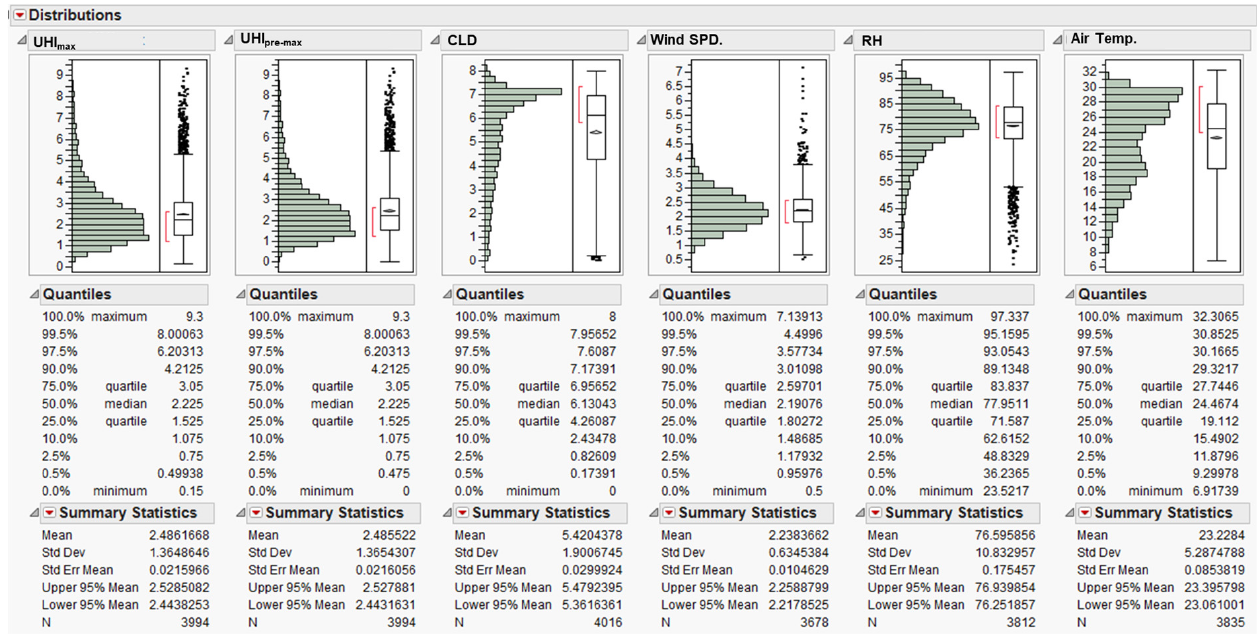
Figure 3. Distribution analysis and summary statistics of meteorological elements and UHI indica- tors in the whole year (mean values of four urban stations of HKOH, JKB, SHA, and TUN, summer, 2002–2012. n corresponds to the number of daily observations during the study period, and incom- plete observations were excluded).